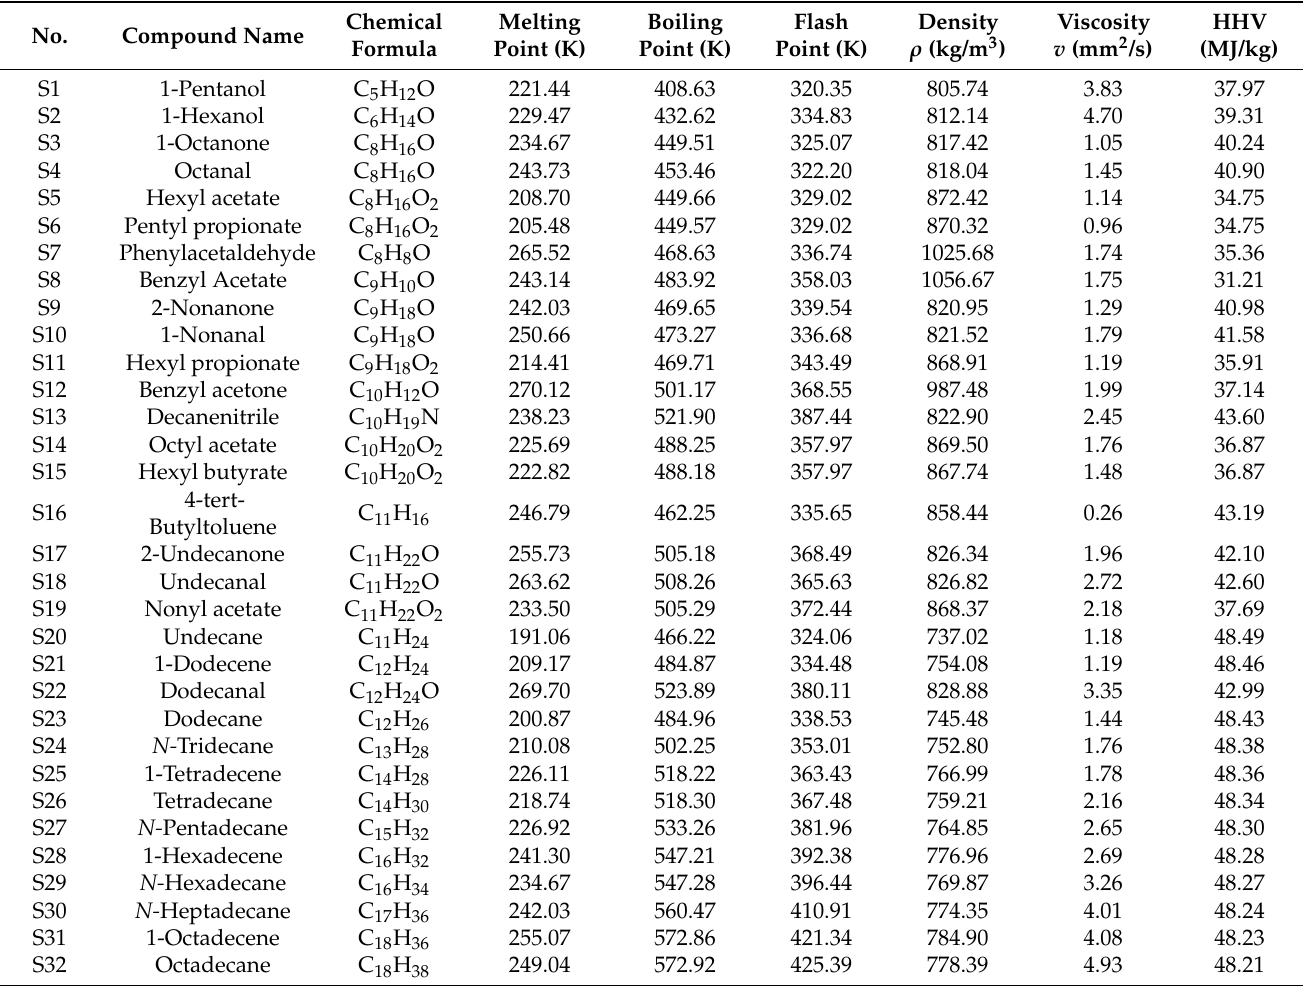
Table 3. Feasible solvent candidates generated from Stage 1